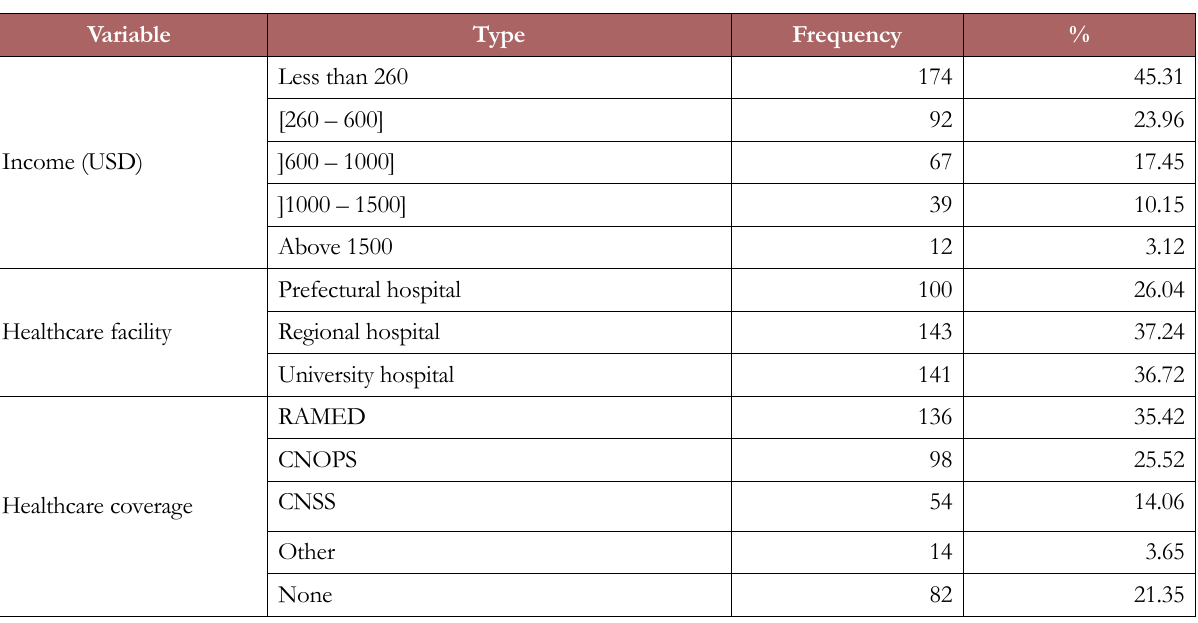
Table 3. Participants’ socio-demographic